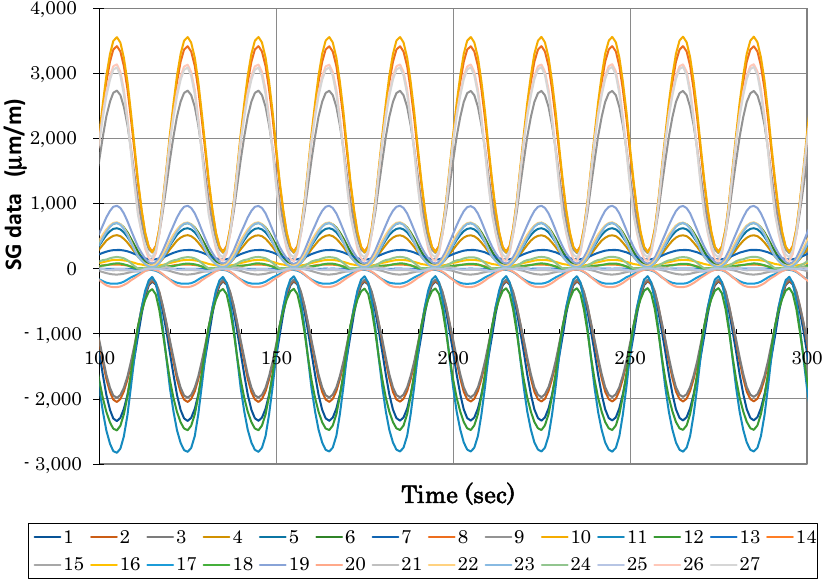
Figure 15. Typical strain gauge curves measured during fatigue test (x in legend corresponds to strain gauge Tx in Figure 9).